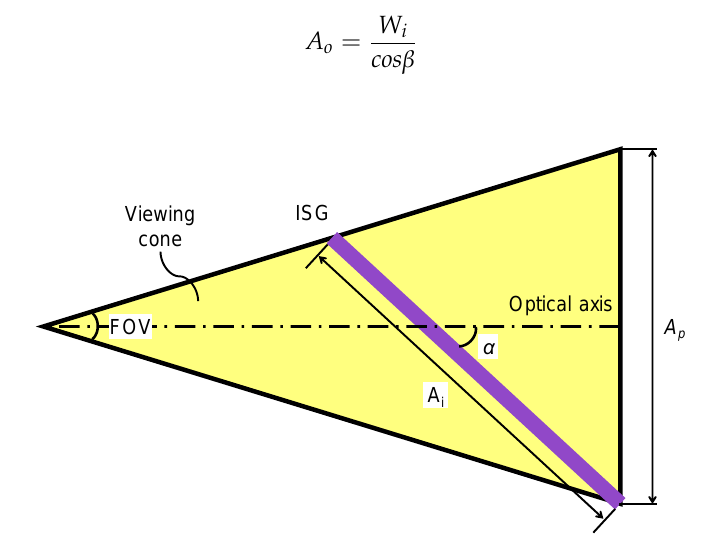
Figure 6. Illustration of the vertical expansion of the exit pupil by the in-coupling slanted grating (ISG). α is the angle between the optical axis of viewing cone and the plane of the ISG, A projection lens, A i the vertical length of intersected exit